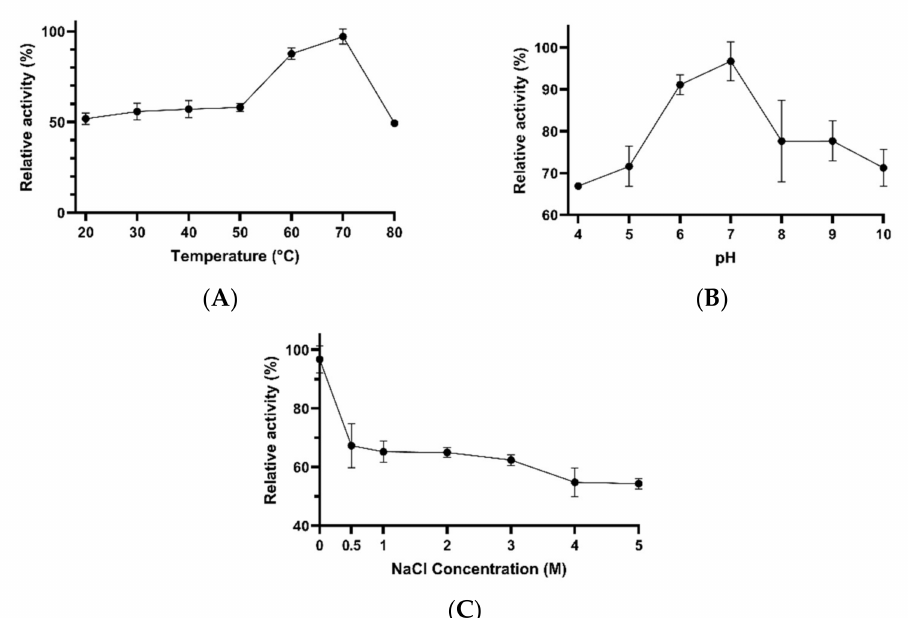
Figure 7. The effects of temperature ( A ), pH ( B ) and NaCl concentration ( C ) on the activity of concentrated cellulases obtained from Bacillus sp. AM N P1.17 Error bars represent the standard deviation of the mean ( n = 3).